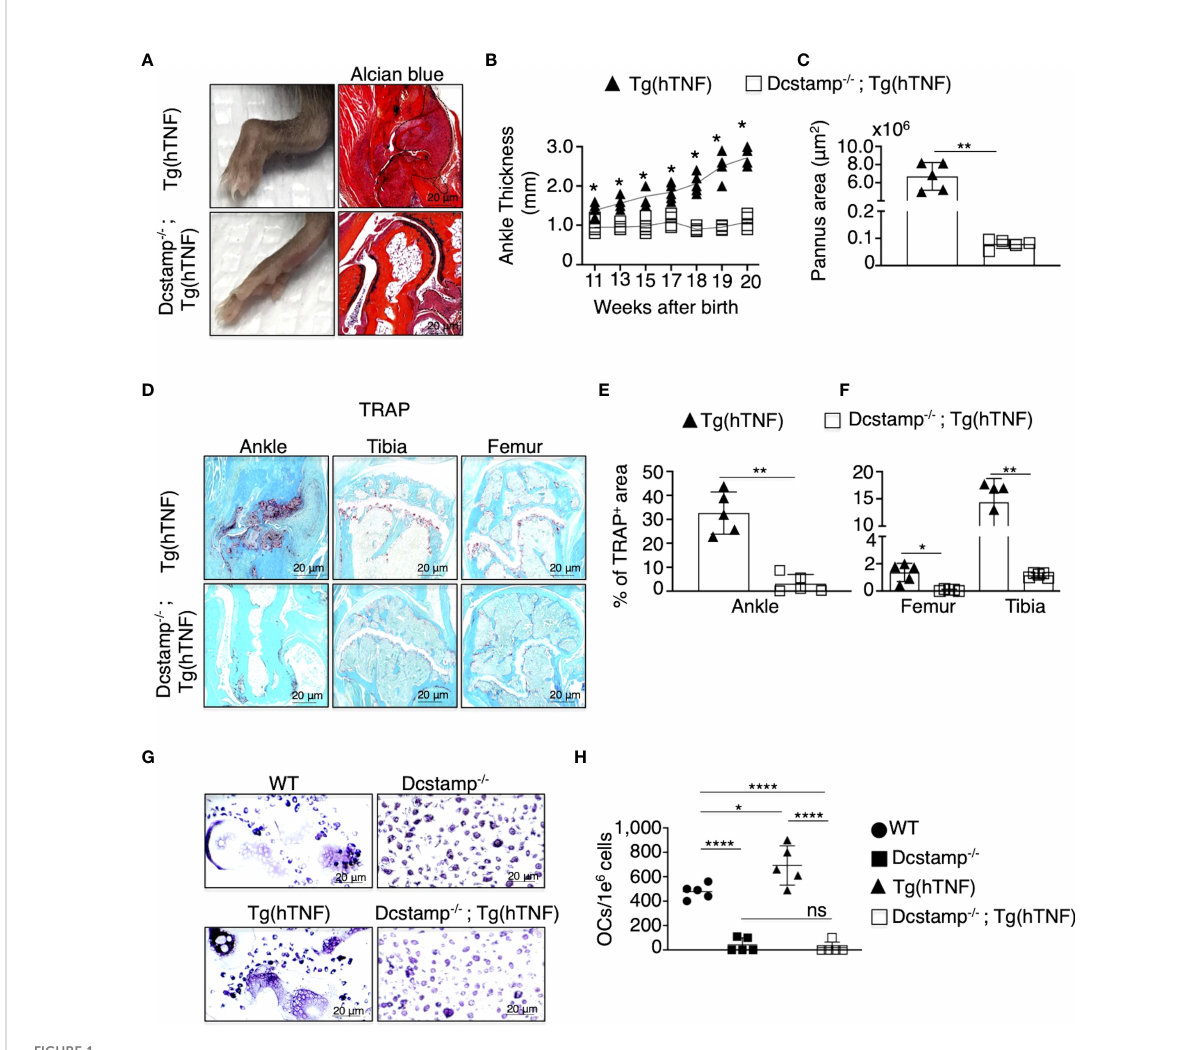
FIGURE 1 In fl ammatory arthritis and pathologic bone resorption are markedly decreased in Tg(hTNF) mice with genetic deletion of Dcstamp. (A) Representative photographs of the hind paw and ankle joint from 5-month-old Dcstamp -/- ; Tg(hTNF) and Tg(hTNF) female mice stained with Alcian Blue. Tg(hTNF) mice have visibly swollen ankles and marked synovial in fl ammation; fi ndings not observed in Dcstamp -/- ; Tg(hTNF) mice. (B, C) show signi fi cant differences in ankle thickness and pannus area in the Tg(hTNF) vs. Dcstamp -/- ; Tg(hTNF) mice. n = 5 (one back paw/mouse), mean ± SD. p=0.05 (two-way ANOVA and Tukey's multiple comparison test.) (D – F) . Morphometric analysis shows signi fi cant reduction in the TRAP+ area of the ankle, tibia and femur of Dcstamp -/- ; Tg(hTNF) vs. Tg(hTNF) mice. 200x magni fi cation pictures captured with a Zeiss Axioplan microscope and recorded with a Hamamatsu camera (D , G) . Scale bars represent 20 um. The area covered by TRAP+ osteoclasts in mouse ankle, tibia and femur was analyzed with NIH Image J software. Graphs represent the mean ± SD (n = 5 mice). ns,